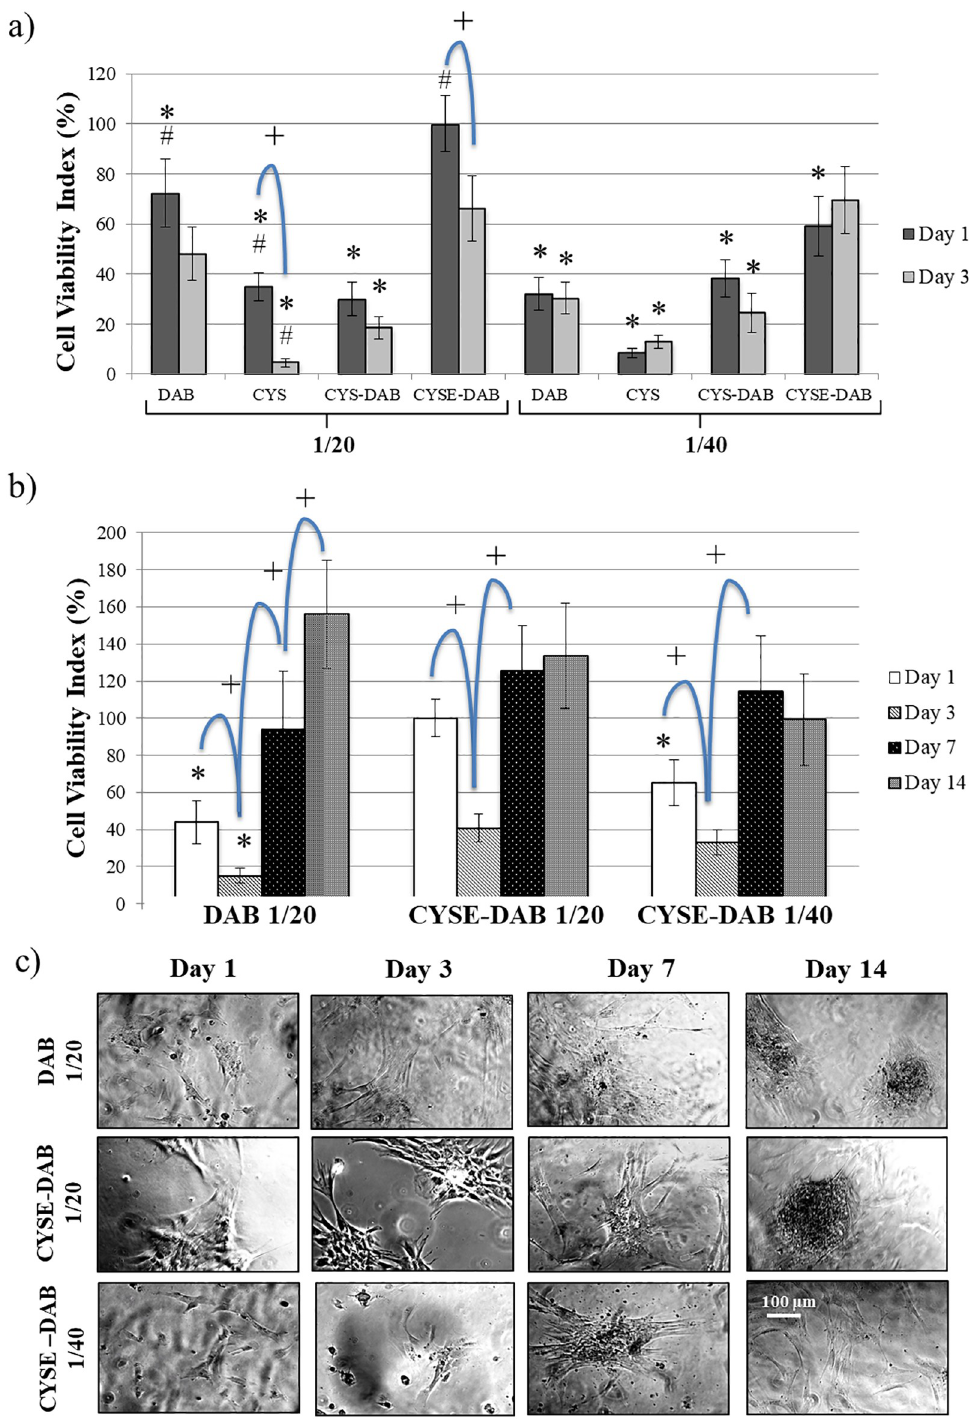
Fig 2. Cell viability on different PASP hydrogels on day 1 and 3 (a), long term viability on PASP-DAB 1/20 , CYSE-DAB 1/20 and CYSE-DAB 1/40 gels (b) and phase-contrast microscopic images of PDLCs in long term experiments at different time points (c). The viability value measured on CYSE-DAB 1/20 gels on day 1 was considered 100%. Data are given as an arithmetic means ± SEM (standard error of the mean). � p < 0.05 compared to CYSE-DAB1/20 at the appropriate time point. +p < 0.05 compared to the next day. Each photomicrograph was taken at the same